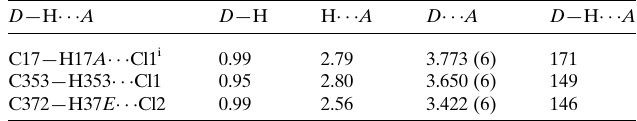
Table 1 Hydrogen-bond geometry (A˚ , (cid:4) ) for (I).